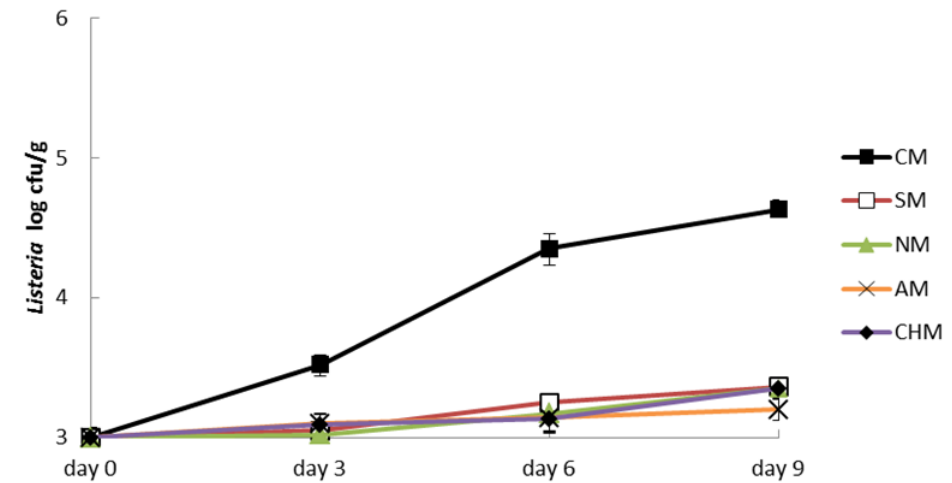
Figure 2. Changes in L. monocytogenes Lhica 4 inoculated in minced meat during storage at 4–6 °C. Control meat (CM), sodium meat (SM), nitrite meat (NM), sodium acetate meat (AM), sodium acetate–chitosan meat (CHM).